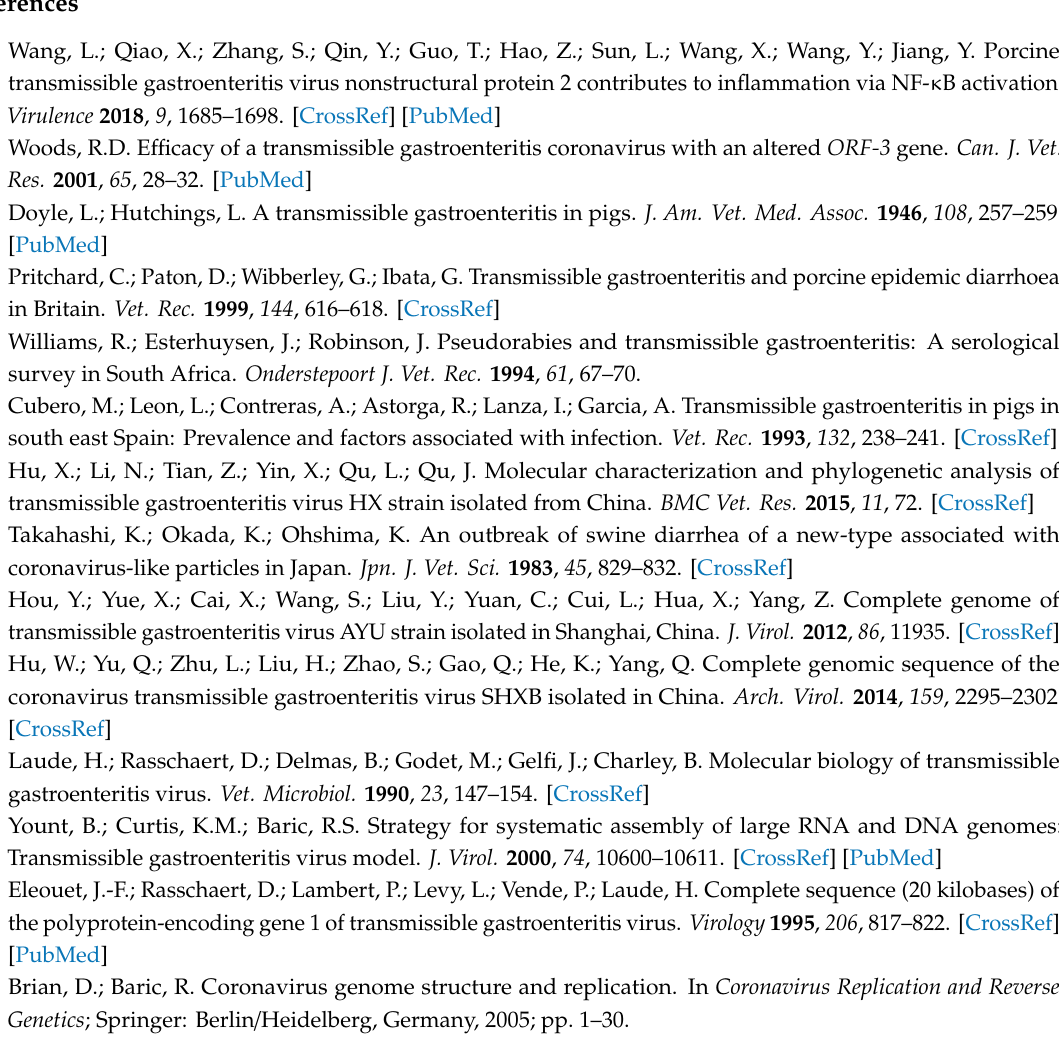
7898 / s1. Figure S1: Recombination analysis of TGEV strains. Figure S2: Phylogenetic trees of the partial spike gene of TGEV. Figure S3: PCA scree plot based on the RSCU values of TGEV complete CDS. Figure S4: The variable correlation plots of PCA. Table S1: The detailed information of TGEV strains used in this study. Table S2: The nucleotide contents and properties of TGEV complete CDS. Table S3: Comparison of nucleotide contents and properties of the ORF1ab gene, spike gene, and TGEV genome complete CDS. Table S4: Comparison of synonymous codon usage of the ORF1ab gene, spike gene, and TGEV genome complete CDS. Table S5: Relative dinucleotide abundance of TGEV complete CDS. Table S6: Comparison of relative dinucleotide abundance of the ORF1ab gene, spike gene, and TGEV genome complete